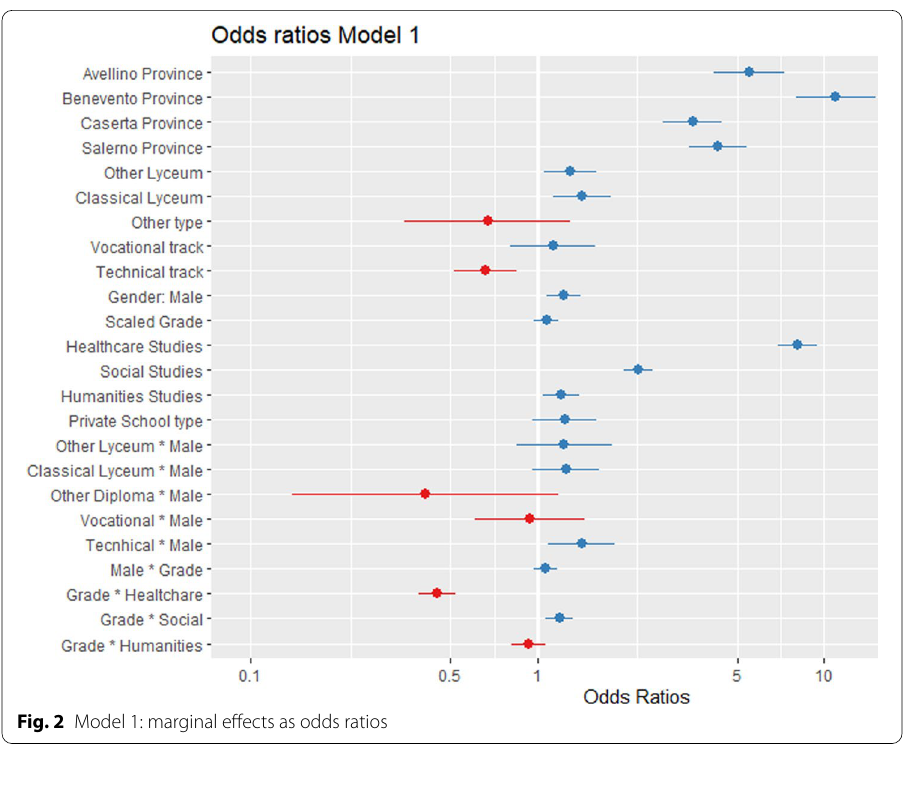
Fig. 2 Model 1: marginal effects as odds ratios